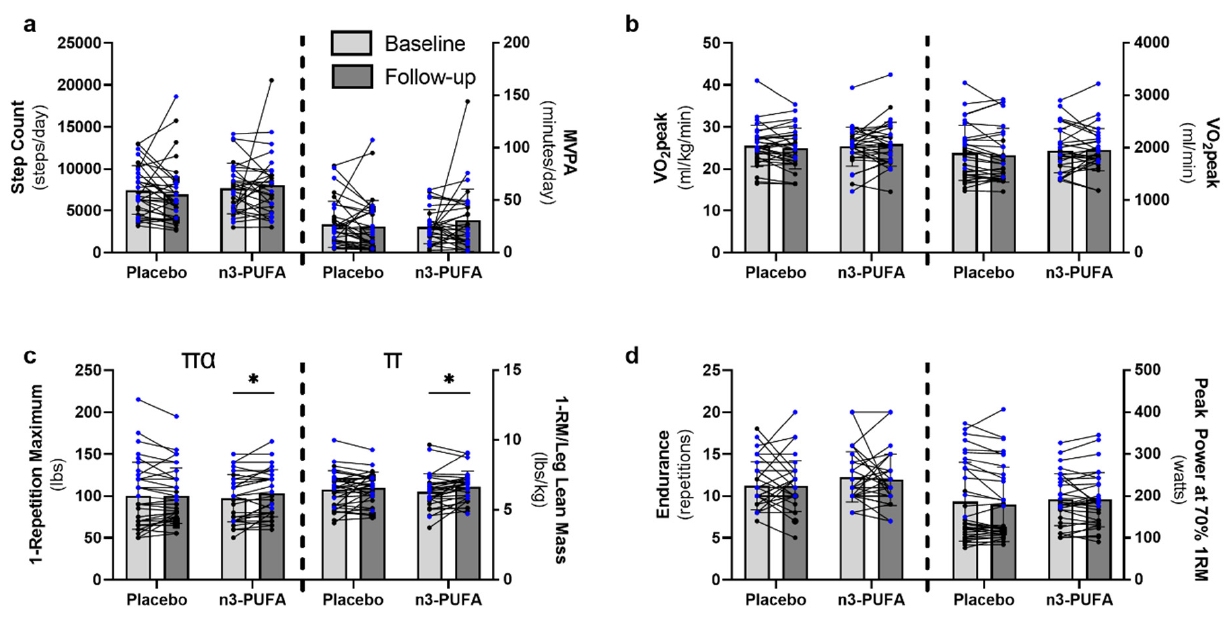
Figure 2. The effects of 6-months placebo or n3-PUFA on physical activity, cardiorespiratory fitness and skeletal muscle function. Free-living physical activity ( a ), cardiorespiratory fitness ( b ), and skeletal muscle strength ( c ), endurance, and power ( d ) were assessed in older adults (65–85 years) before and after 6 months of supplementation with either placebo or n3-PUFA. ( a ) Free-living physical activity was assessed by waist-worn accelerometers and defined as the number of steps per day or the number of minutes of moderate to vigorous physical activity (MVPA) per day (placebo: n = 33; n3-PUFA: n = 29). ( b ) Cardiorespiratory fitness (VO 2 peak) was determined with indirect calorimetry during a maximal graded treadmill test and expressed per kg body weight or as absolute oxygen consumption (placebo: n = 30; n3-PUFA: n = 30). ( c ) Single leg extension 1 repetition maximum (1-RM) was determined to assess muscle strength and is presented as absolute strength and as strength normalized to leg lean mass (placebo: n = 33; n3-PUFA: n = 30). ( d ) Single leg muscle endurance was defined as the maximum number of full repetitions that could be performed at 70% of the individual 1-RM, and single leg peak power was assessed at 70% of the individual 1-RM (placebo: n = 33; n3- PUFA: n = 30). Mixed repeated measures ANOVAs were performed to determine the within-sub- jects effects of time (baseline, follow-up), the between-subjects effects of the intervention (n3-PUFA, placebo) and the interaction between time and intervention. Post hoc pairwise comparisons were performed when significant main or interaction effects were identified. Significance was set a priori at p < 0.05. Individual data points represent individual participants, with blue data points represent- ing males and black data points representing females. Bars indicate mean and standard deviation. π represents a significant main effect of time; α represents a significant time-by-intervention inter- action; * represents a significant within-group difference between baseline and follow-up. 3.3. Mitochondrial Function Supplementation with n3-PUFA did not influence skeletal muscle mitochondrial function (Figure 3). Mitochondrial respiration (Figure 3a), ATP production (Figure 3b), and ROS generation (Figure 3c) were similar between the n3-PUFA and the placebo group at baseline, and these measurements did not significantly change over the course of the intervention in either group. While there was a modest trend for an overall reduction in ROS generation normalized to oxygen consumption over time (time effect F = 2.884, p = 0.095), pairwise post hoc comparisons did not find significant reductions in ROS genera- tion in either the placebo ( p = 0.376) or n3-PUFA group ( p = 0.141).